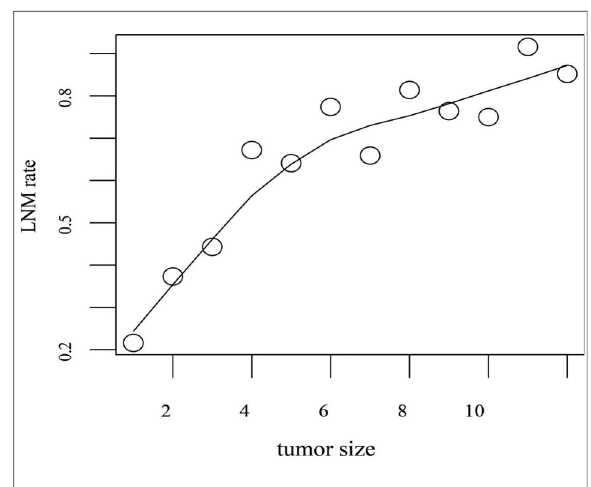
FIGURE 2 Tumor size counts are recorded over 1-cm intervals. LNM rate refers to the proportion of patients with LNM to all patients in the training set within the range of unit tumor size. LNM rates are adjusted for tumor size. Abbreviation: LNM, lymph node